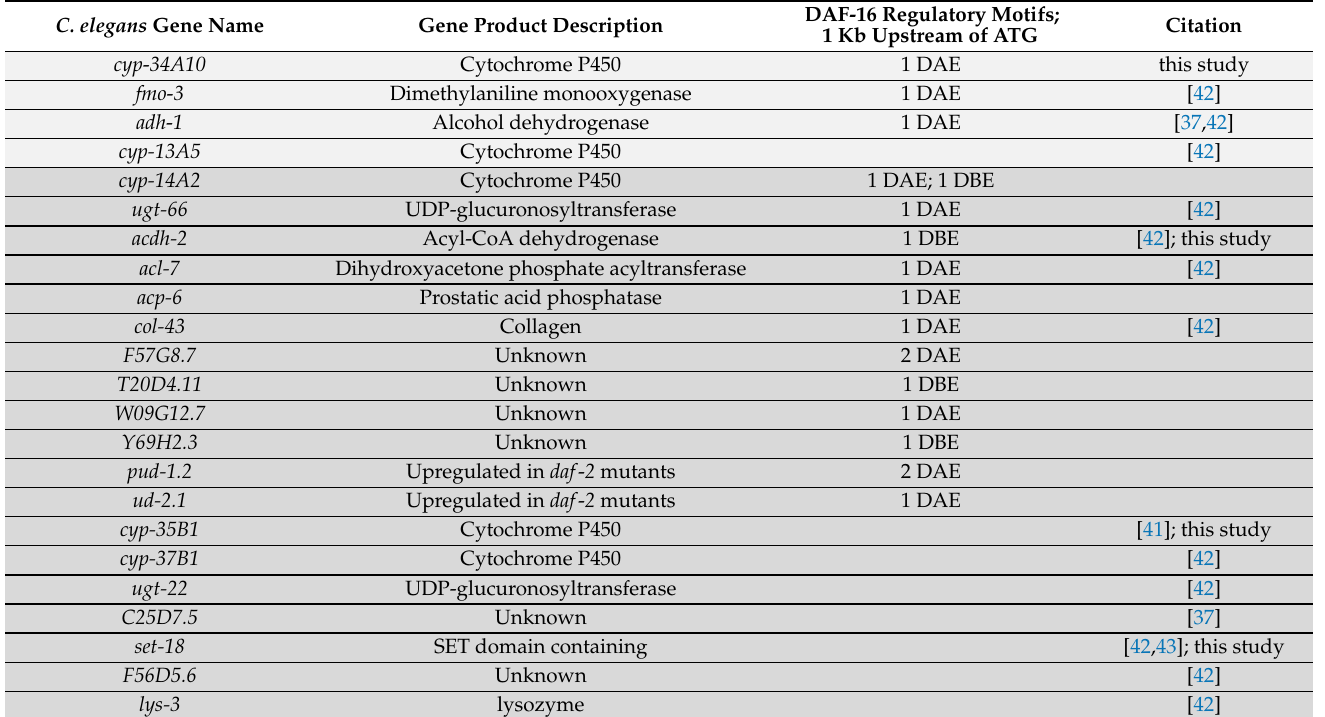
Table 4. DEGs with evidence for DAF-16 regulation. Shaded rows indicate day 5 and 7 DEGs (light and dark, respectively).